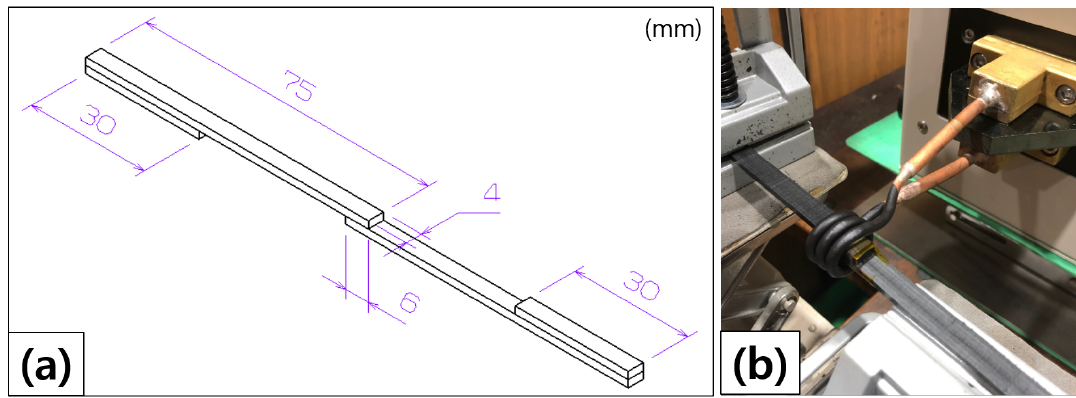
Figure 4. Induction welding of thermoplastic composites: ( a ) drawing of the specimen and ( b ) specimen and experimental